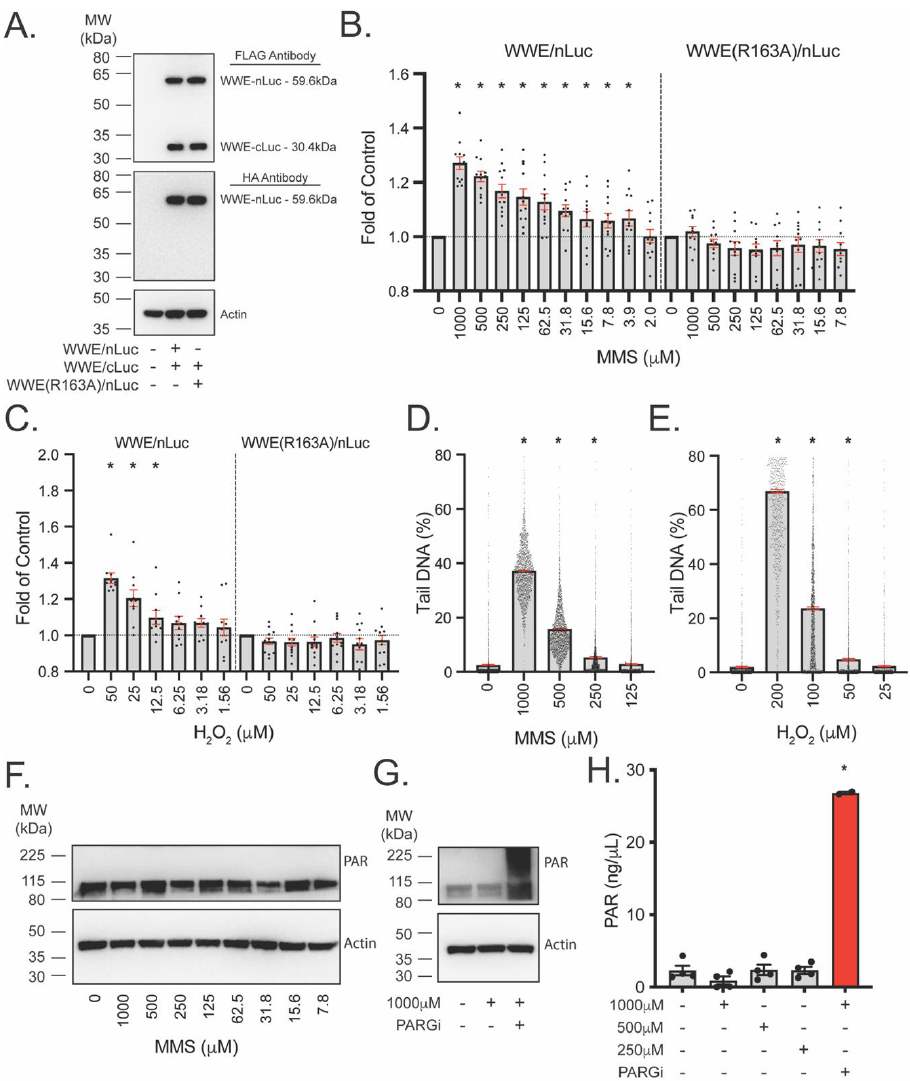
Figure 5. Sensitivity of the single vector WWE split luciferase (Luc) assay. ( A ) Expression of WWE- nLuc and WWE-cLuc in U2OS cells using a single lentiviral vector. WWE(R163A)-nLuc was alter- natively expressed to control for luciferase binding effects and serve as a non-PAR binding control. ( B ) PAR formation following 30 min MMS dose–response. Values are normalized to untreated controls. ( C ) PAR formation following 30 min H 2 O 2 dose–response. ( D ) CometChip results following 30 min MMS dose–response. ( E ) CometChip results following 30 min H 2 O 2 dose–response. ( F ) Immunoblot for PAR formation in U2OS cells following 30 min MMS dose–response. ( G ) Immunoblot for PAR formation in U2OS cells following 30 min MMS (1000 µ M) with or without PARGi pre-treatment (PDD00017273; 10 µ M, 1 h). ( H ) PAR ELISA results following 30 min MMS (1000 µ M) with or without PARGi pre-treatment (PDD00017273; 10 µ M, 1 h). For ( B , C ), each dot represents a single plate reading, with mean and SEM (red bars) shown; N ≥ 8 reads. * p < 0.05 using a one-sample t -test. For ( D , E ), each dot represents a single cell, with mean and SEM (red bars) shown; * p < 0.05 using an ANOVA with Tukey post hoc test when compared to untreated control. For ( H ): * p < 0.05 using an ANOVA with Tukey post hoc test when compared to untreated